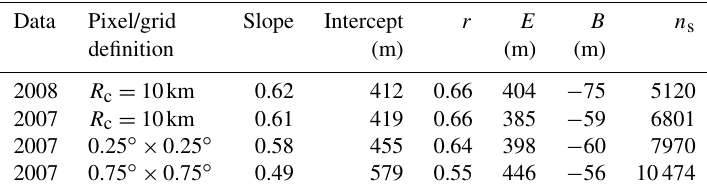
Figure 7. (a, b) Joint density of z base and ˆ z base for the year 2008 (a, c) which is used to estimate parameters of the algorithm and for the year 2007 (b, d) which is used to validate the stability of the algorithm with the estimated parameters. The value of the normalized density is indicated by color (maximum values in light yellow) and contour lines with corresponding values on them (linear scale). For each ceilometer height bin, the mean (red) and median (blue) of the MISR z base are shown. (c, d) Probability density functions of the residuals after a linear fit (red), the retrieval differences (blue) and a normal distribution with a standard deviation of 250m (black). Table 4. Slope, intercept, correlation coefficient r , RMSE E , bias B and number of retrievals n s resulting from a comparison of z base and ˆ z = 10 and P = 15. base for data obtained in 2008 (calibration) and 2007 (validation). These values are obtained with N Data Pixel/grid Slope Intercept r E n